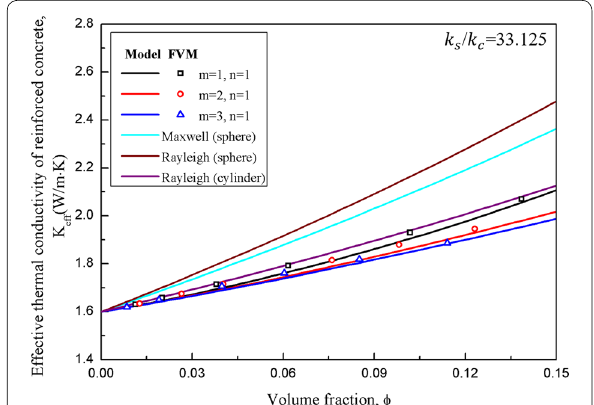
Fig. 9 Effective thermal conductivity of reinforced concrete versus volume fraction at the normal to heat transfer direction.